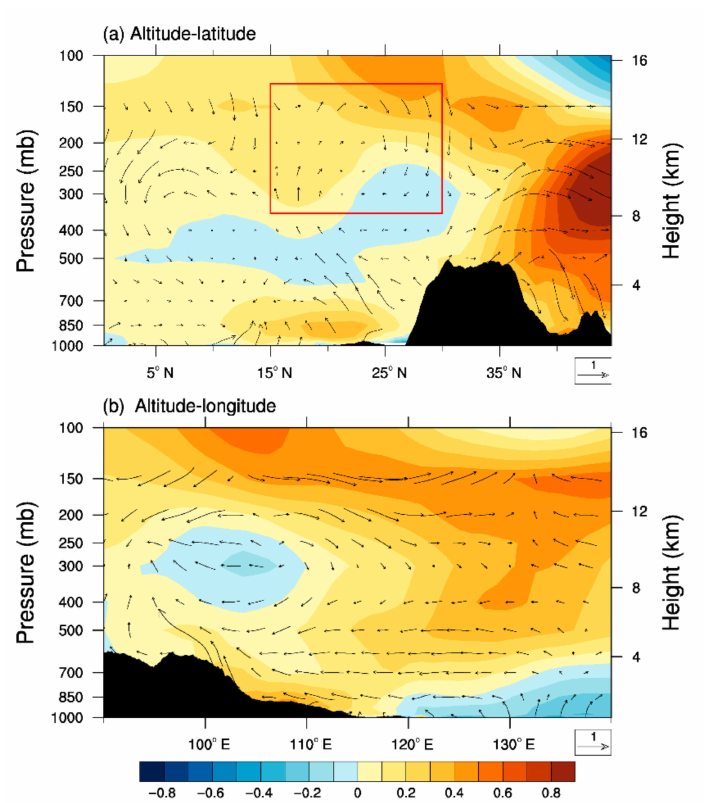
Figure 9. ( a ) Altitude–latitude cross-section of the changes in zonal mean air temperature (colors, K) and wind field (arrows) averaged along meridian region of 60 ◦ E–120 ◦ E in the latitude zone of 27 ◦ N–42 ◦ N in the summer for period from 2001 to 2005. ( b ) Same as ( a ) but for altitude–longitude cross-section of meridional means along latitude region of 27 ◦ N–42 ◦ N in the longitude zone of 60 ◦ E–120 ◦ E. Red rectangle indicates the area of anticyclonic circulation induced by